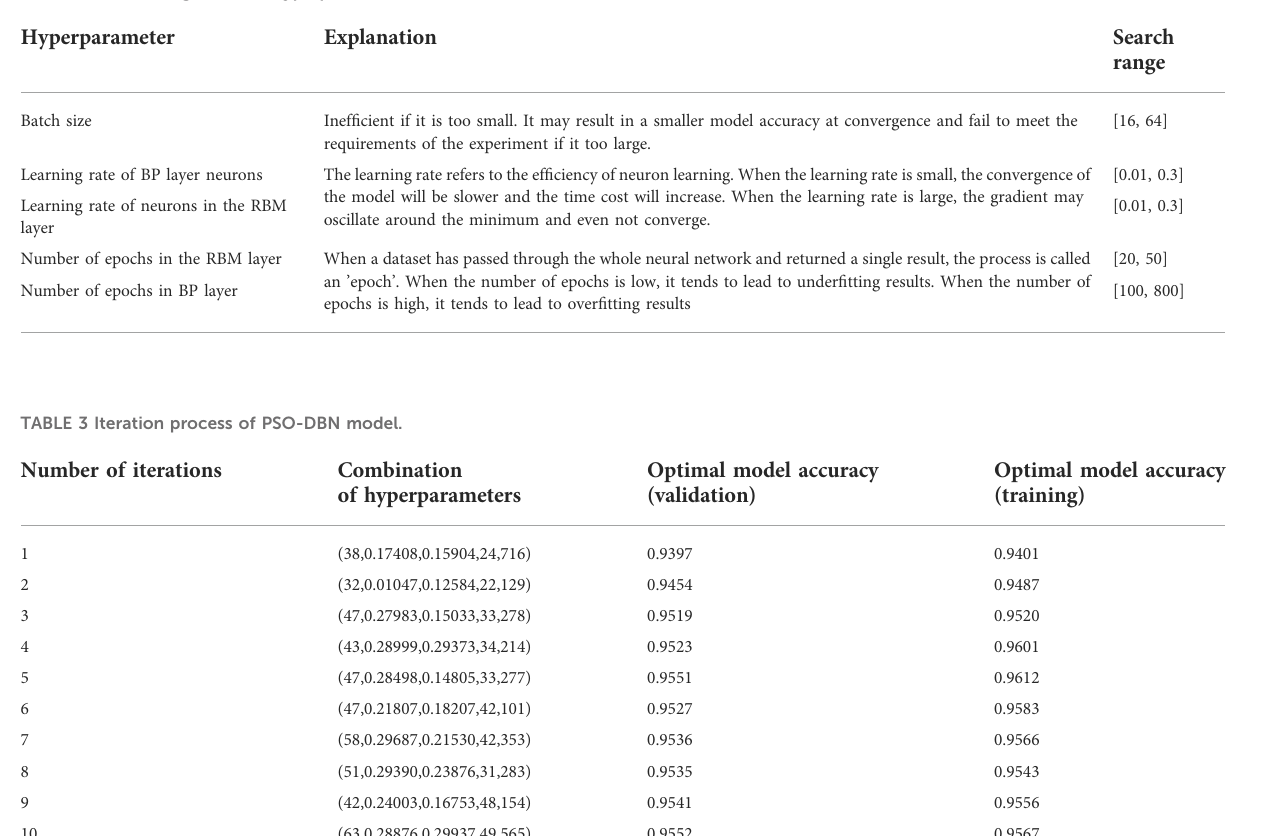
TABLE 2 Search range of DBN hyperparameters.